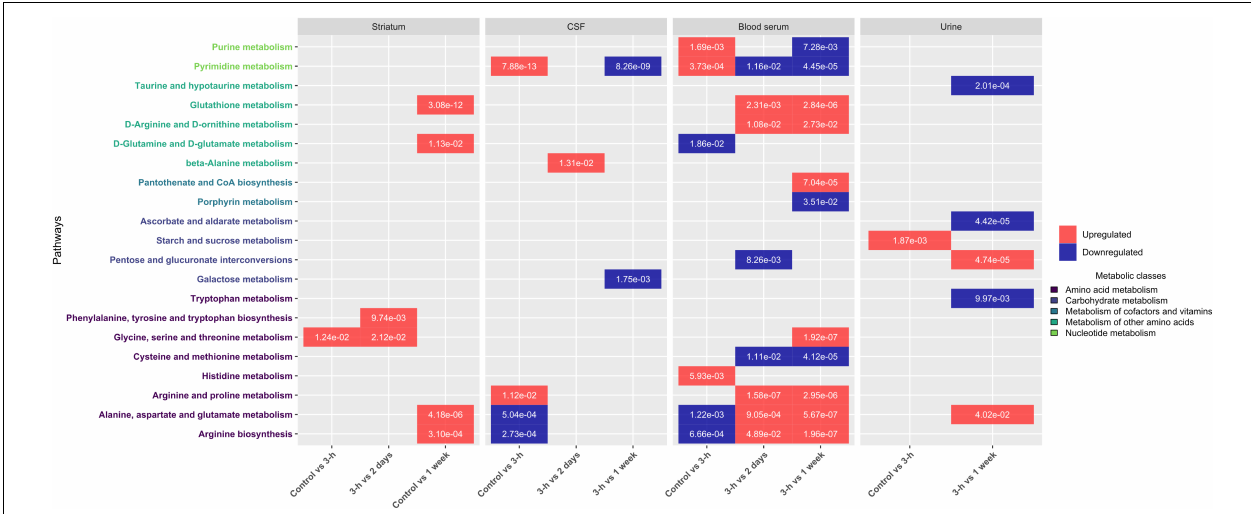
FIGURE 7 | Impacted pathways in cerebral and peripheral metabolomes after acoustically-mediated BBB opening (BBBO). The adjusted p -value is written into tiles. Dysregulation is represented in red and blue, respectively for upregulation and downregulation of the considered pathway. Pathway names are coded with colors depending on their metabolic